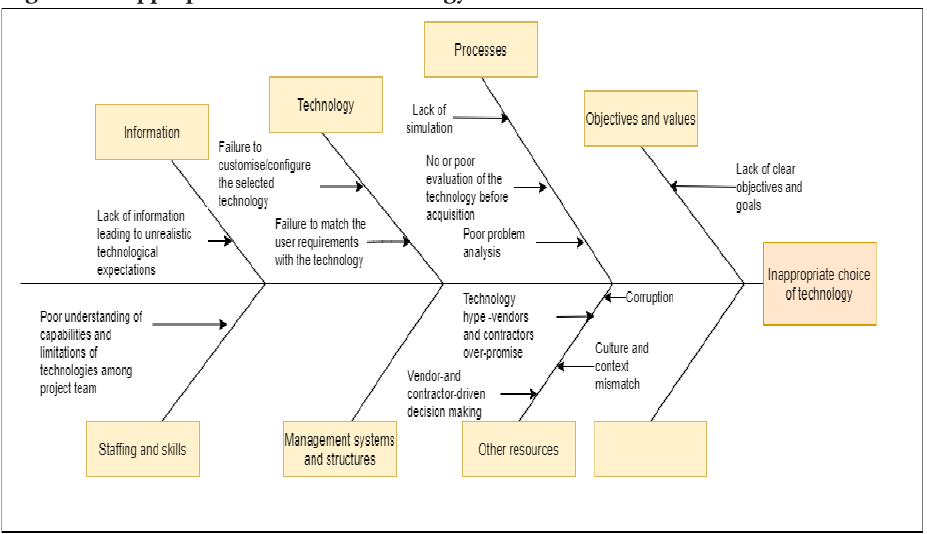
Figure 6: Inappropriate choice of technology